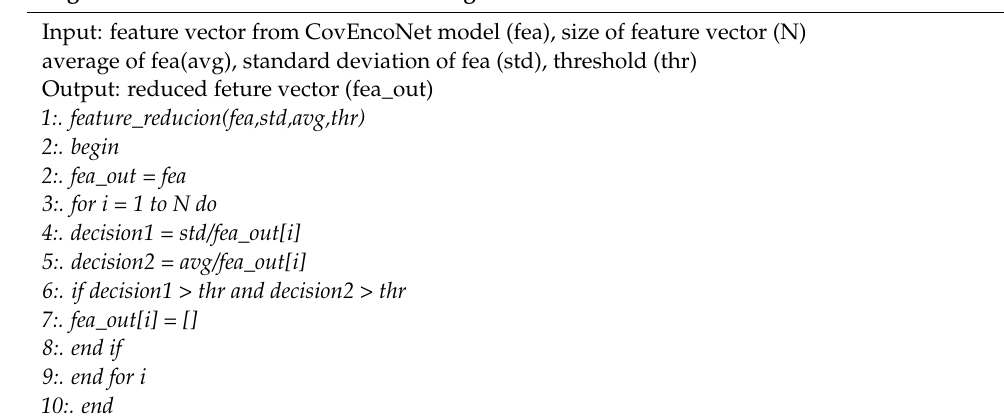
Algorithm 1. Pseudocode of the NCAR